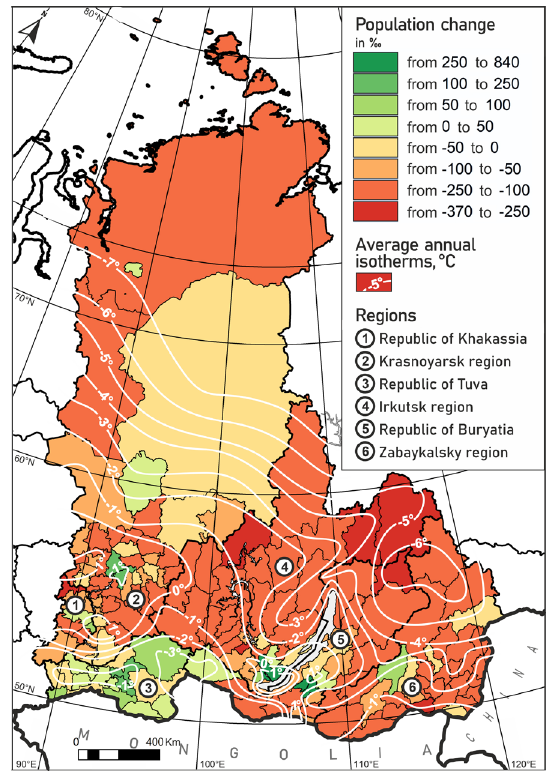
Fig. 2. Population change in 2010–2019 per 1,000 people and the average annual temperature in municipalities of the East Siberian economic district (temperatures are shown only in the range from −7°C to +1°C, in mountainous areas may differ significantly from those